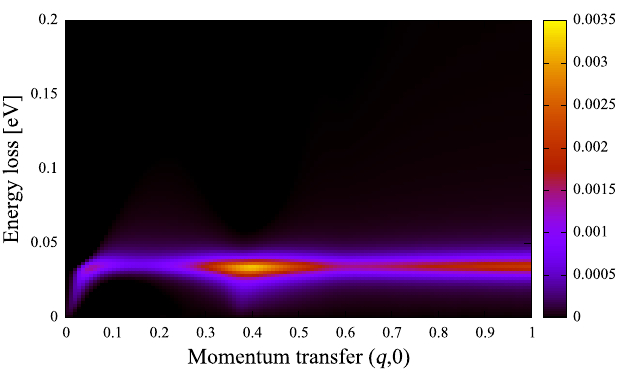
FIG. 5. B 1 phonon contribution to RIXS. Momentum transfer is given in units of π =a .